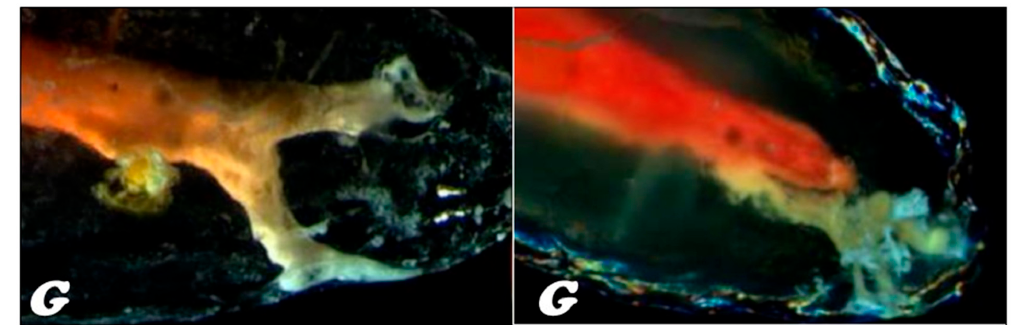
Figure 27. The structure of filling the delta zone of the root canal after obturation with the THC technique of hot thermo- plastic condensation with the use of a filling material based on gutta-percha ( G ) in teeth subjected to decalcification with a sealant; LSM.